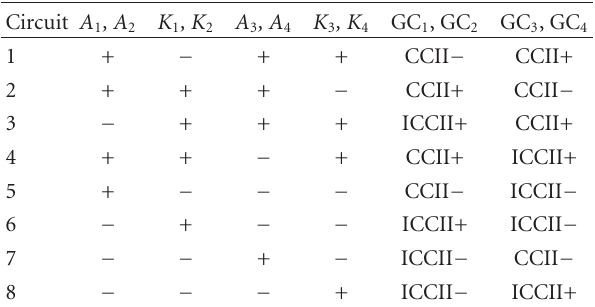
Table 2: Eight alternative conveyor circuits based on Figure 5(b).